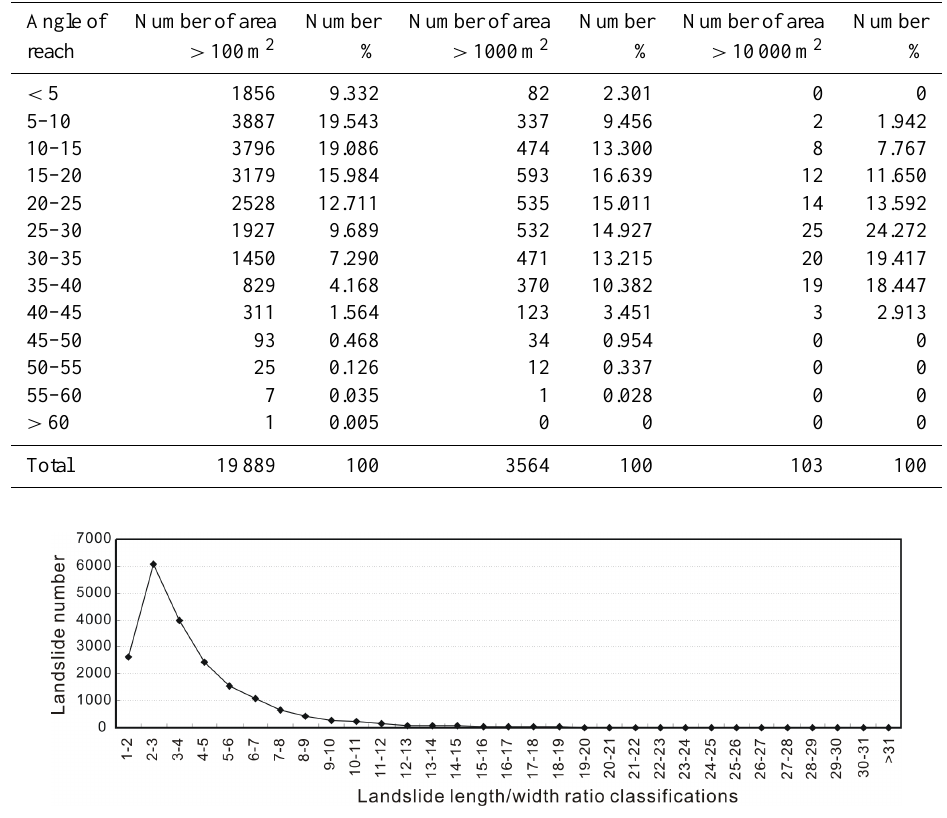
Figure 14. Landslide length/width ratio distribution.